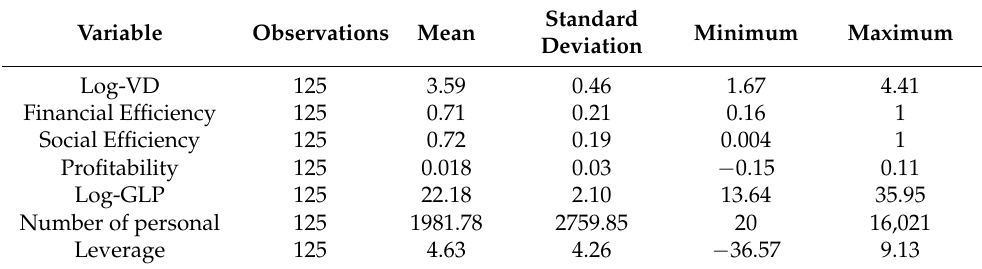
Table 8. Descriptive